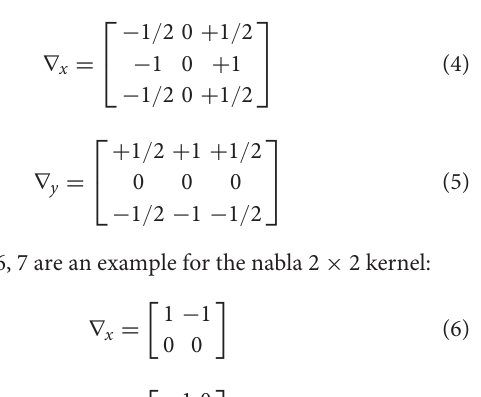
Algorithm 1 – Image Processing-Based Algorithm